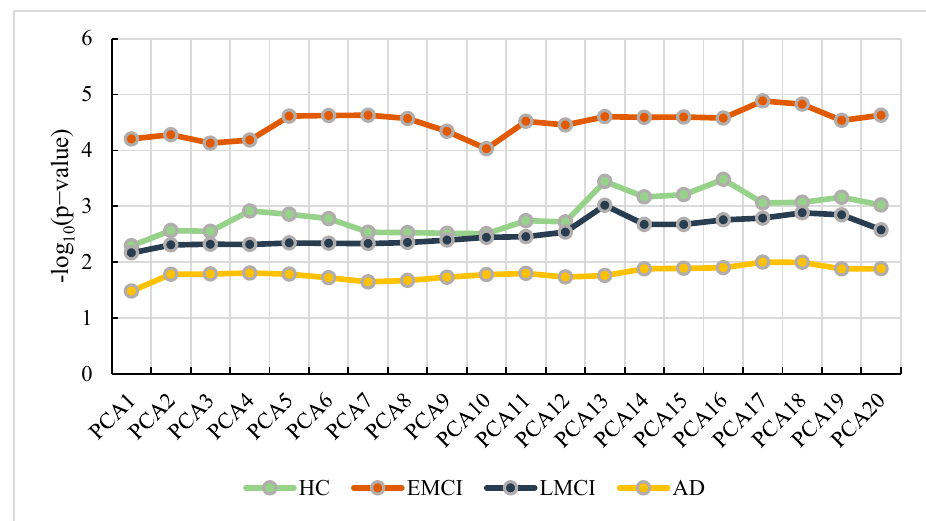
Figure 2. The number of PCA vs. the corresponding p -value of APP.